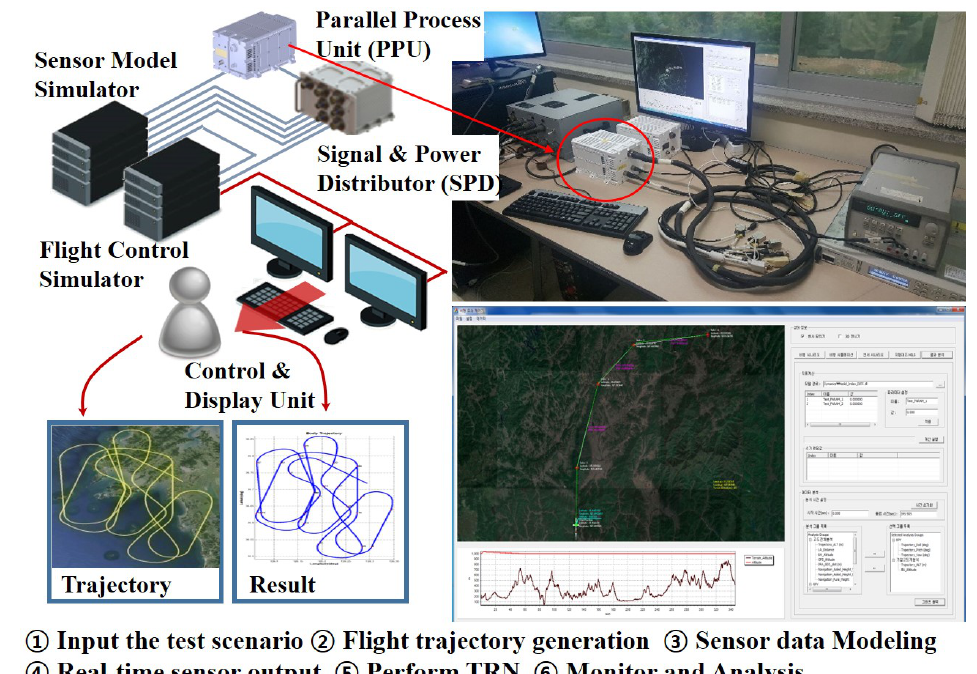
Figure 6. Software-in-the-loop (SIL) experiment configuration for the proposed